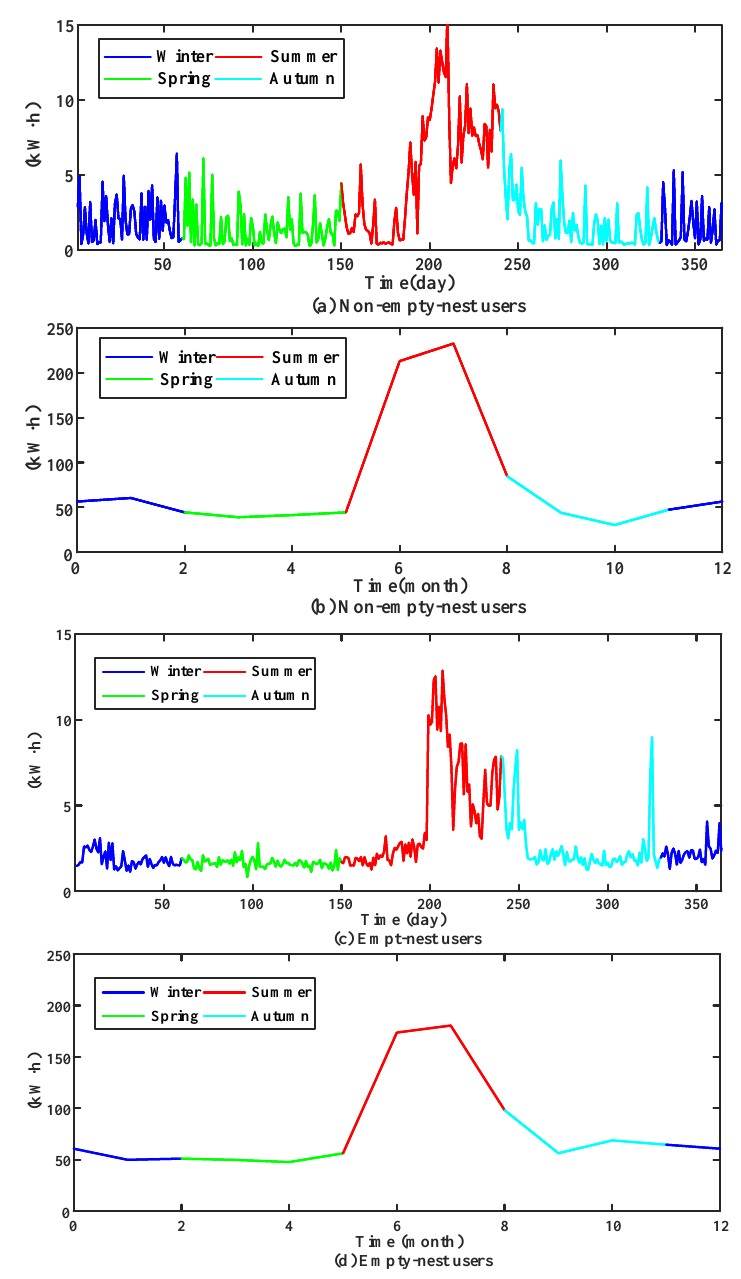
Figure 1. Electricity consumption pattern of empty-nest users and non-empty-nest users. The daily and monthly electricity consumption of the non-empty-nest users and the empty-nest users shown in Figure 1 are relatively similar. Hence, the simple